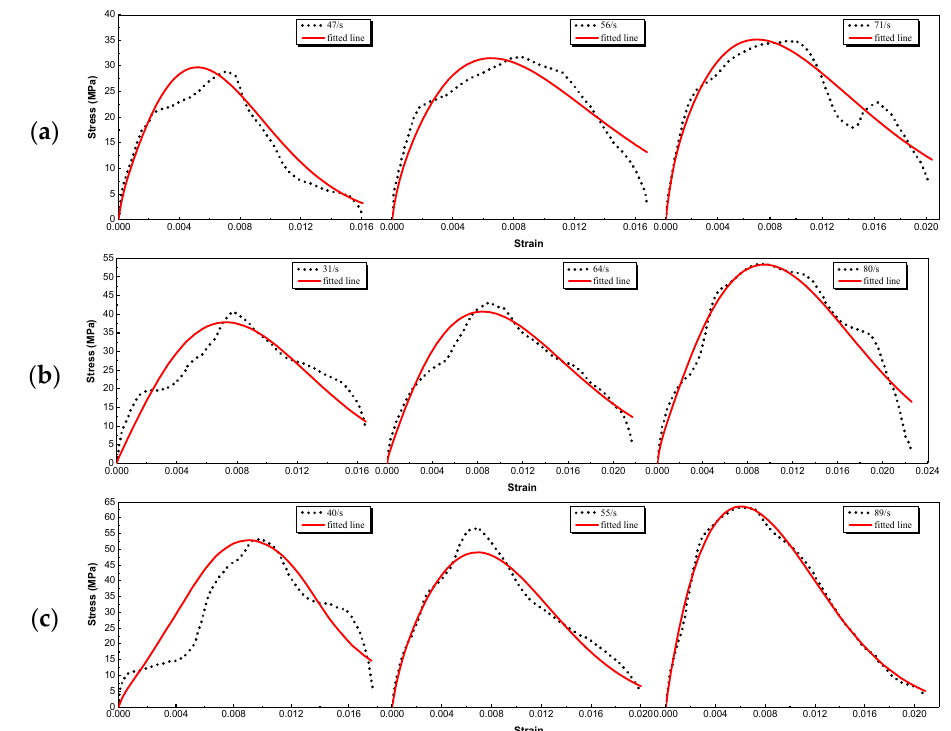
Figure 18. Experimental and fitted stress–strain curves at di ff erent strain rates: ( a ) BC– w / c ratio: 0.68;